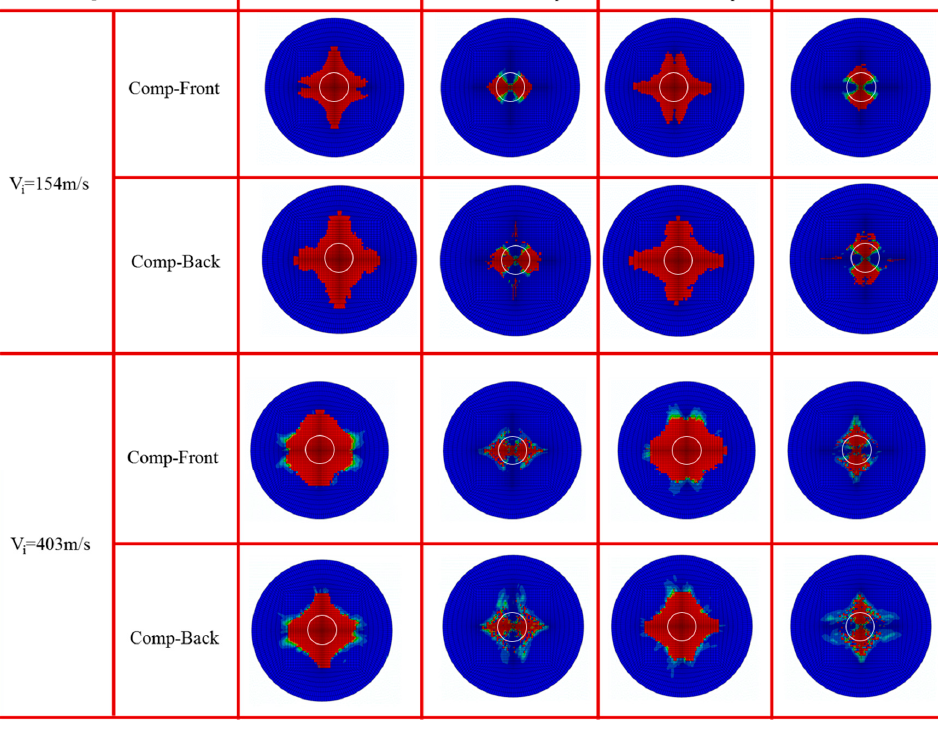
Figure 12. Fibre and matrix failure mode shape of the TFML 3/2 target.